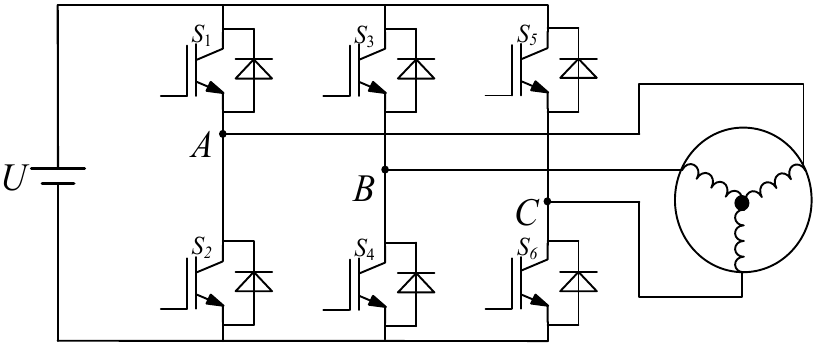
Figure 8. Electrical connection diagram of three-phase inverter and motor